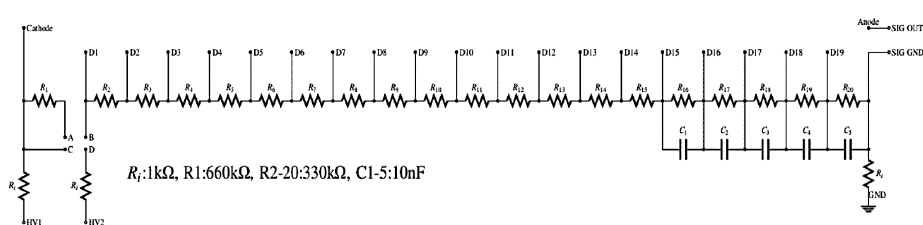
Figure 2. The circuit diagram of the baseboards for the powering and readout of a single PMT in the SE